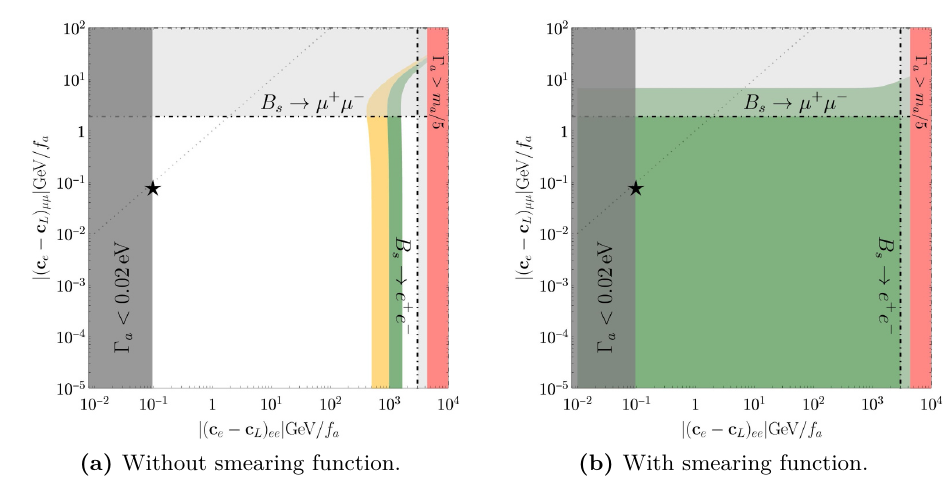
Figure 12. ALP mass just under the low bin window. Impact of the smearing function in the parameter space | ( c ) vs. | ( c ) of solutions to the low bin R anomaly; e − c L ee | /f a e − c L µµ | /f a K ∗ 1 σ (2 σ ) allowed regions depicted in green (yellow), for m = 210 MeV and | ( c ) = a d − c Q sb | /f a 7 . 96 × 10 − 10 GeV − 1 . The figure on the left (right), does not (does) include the smearing function. The dotted line represents the flavour universal setup for the lepton couplings and the black star the smallest allowed value. The dark grey regions are excluded by the prompt decay condition, while the light grey ones are excluded by B + ‘ − s → ‘